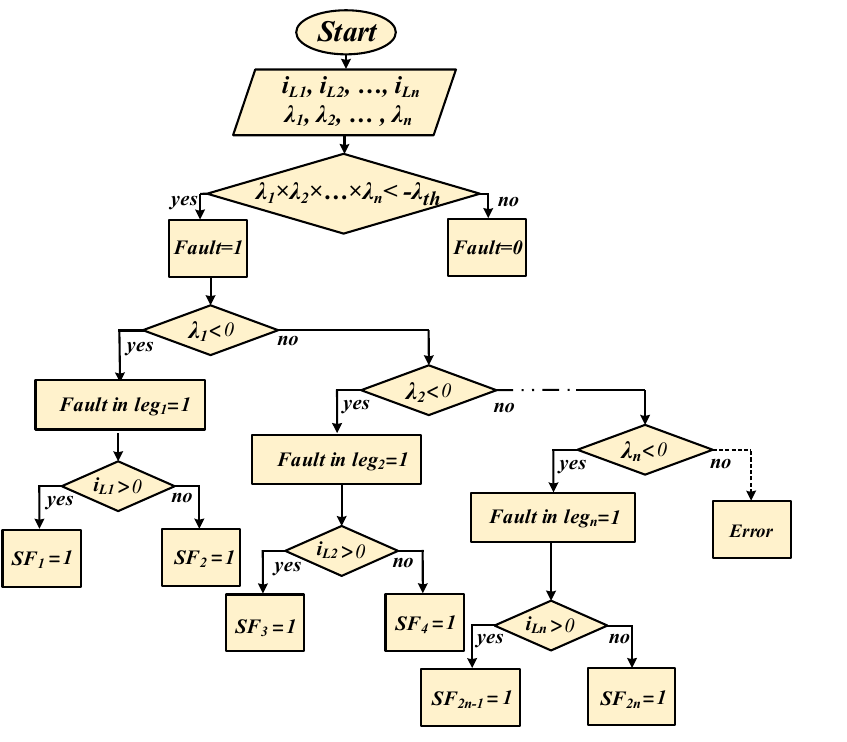
Figure 8. Fault diagnosis algorithm.